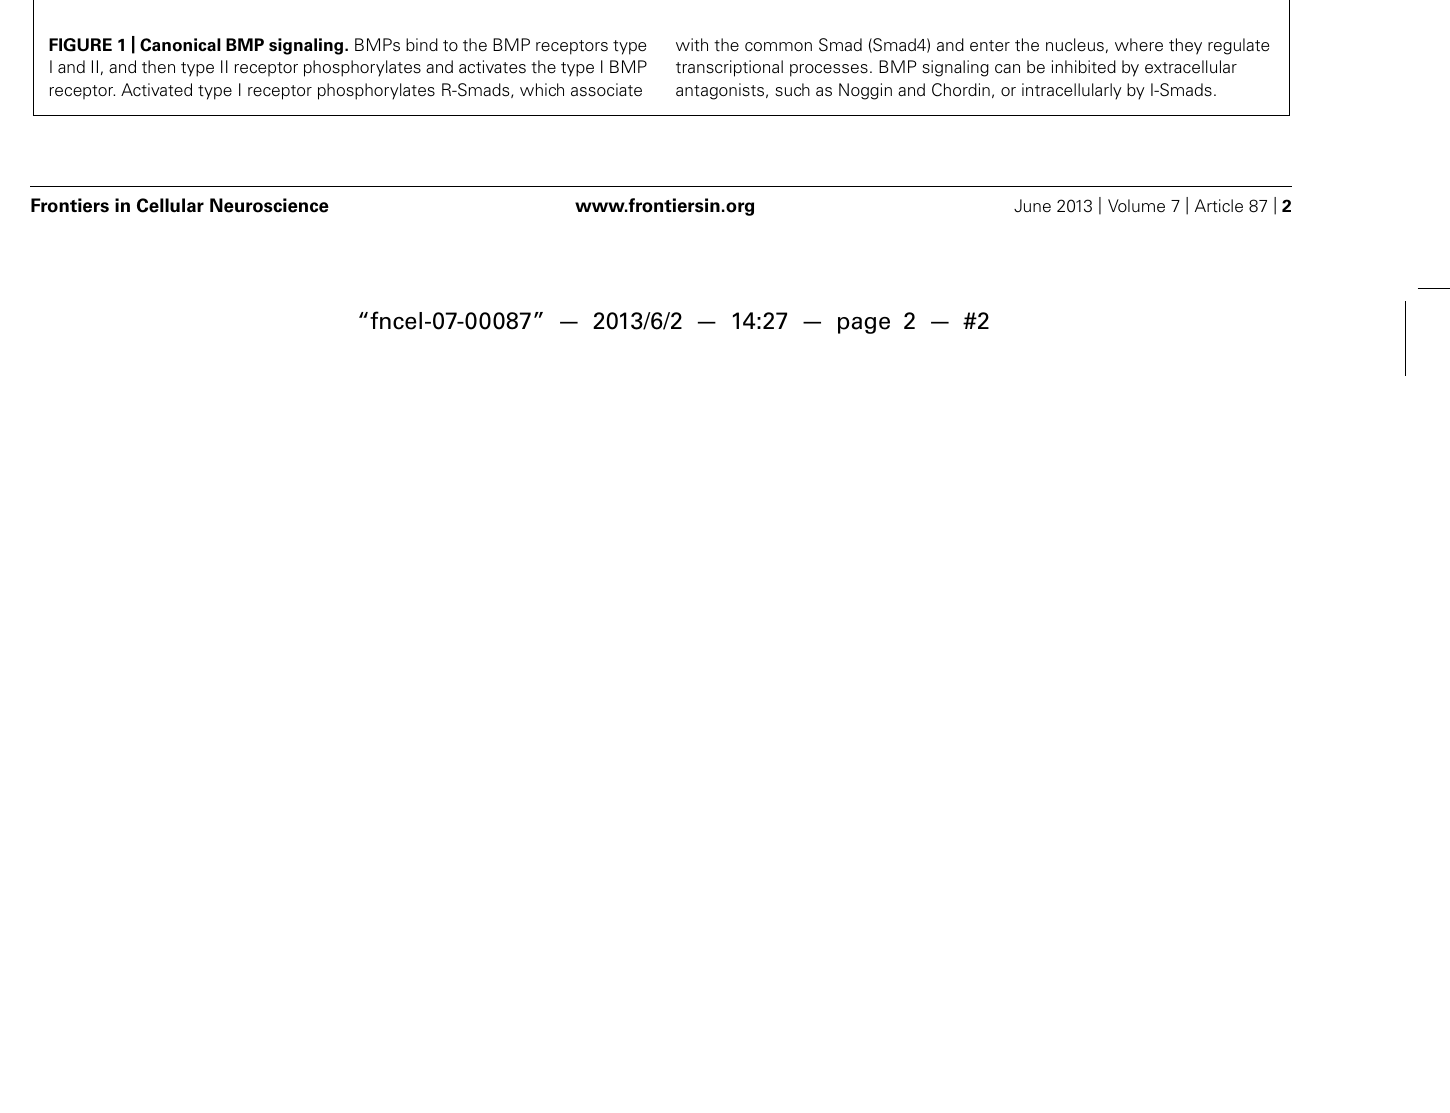
FIGURE 1 | Canonical BMP signaling. BMPs bind to the BMP receptors type I and II, and then type II receptor phosphorylates and activates the type I BMP receptor. Activated type I receptor phosphorylates R-Smads, which associate